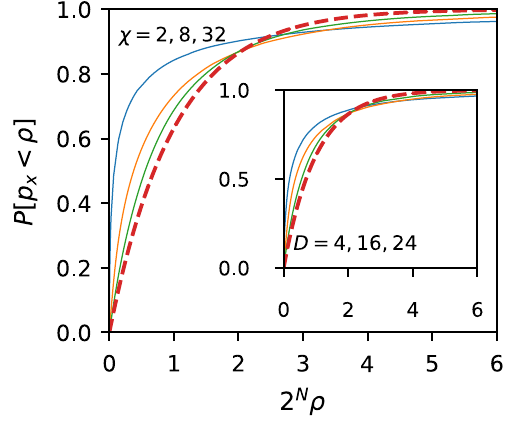
< ρ Þ , where p x j Ψ ij 2 FIG. 3. Cumulative distribution P ð p x x ¼jh for N ¼ 15 . The dashed line corresponds to the Porter-Thomas ρ Þ ¼ 1 − ð 1 − ρ Þ 2 N − 1 . Main panel: MPS simu- distribution, P PT ð lations with truncation, D ¼ 24 , and various MPS truncation levels χ ¼ 2 (blue line), 8 (orange line), and 32 (green line). Inset: exact results (i.e., simulations without truncations) for D ¼ 4 (blue line), 16 (orange line), and 24 (green line). A single realization of the circuit has been used for each